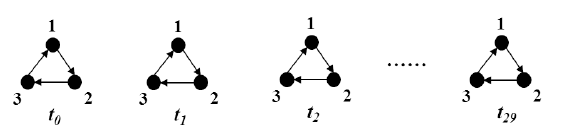
Figure 4. Three nodes send messages to each other in 30 s. The order that three nodes periodically send information at each time is 1 → 2, 2 → 3, 3 →